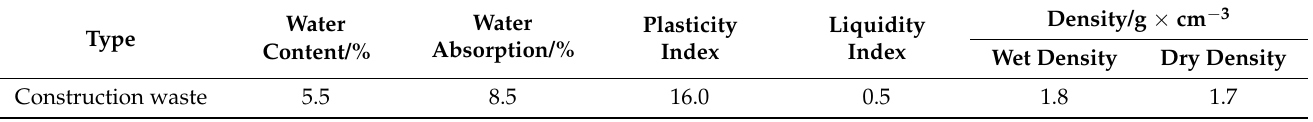
Table 2. Physical properties of construction